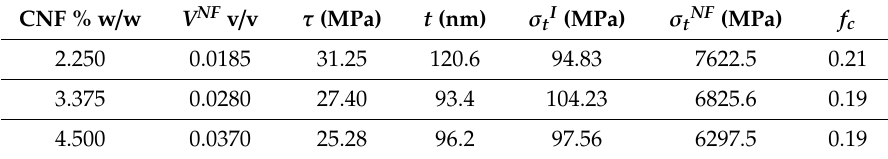
Table 1. Micromechanics of the tensile strength of PVA / CNF